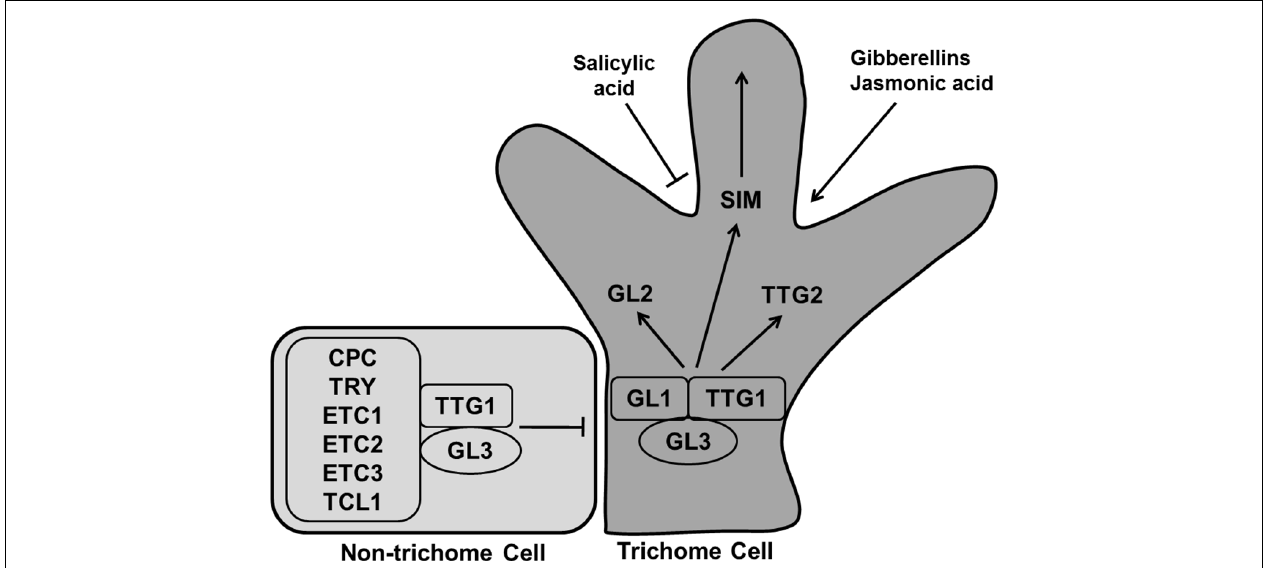
FIGURE 12 | Regulation of trichome differentiation. Transcription factors GLABRA1 (GL1), GLABRA3 (GL3), andTRANSPARENTTESTA GLABRA1 (TTG1) forming the MYB/bHLH/WD-repeat complex activates trichome development whereas CAPRICE (CPC),TRIPTYCHON (TRY), ENHANCER OF TRY AND CPCs (ETC1, ETC2, and ETC3), andTRICHOMELESS1 (TCL1) inhibit